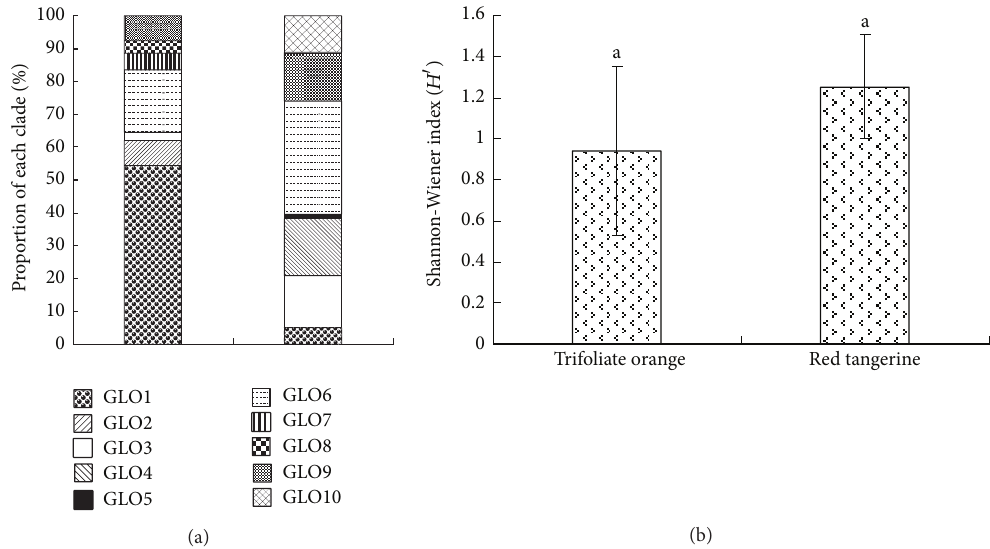
Figure 5: Bar plot showing the relative proportions (a) and Shannon-Wiener index (b) of the observed clades in the two AM fungal analyzed libraries of trifoliate orange and red tangerine. Bars with the same letter are not significantly different at the 0.05